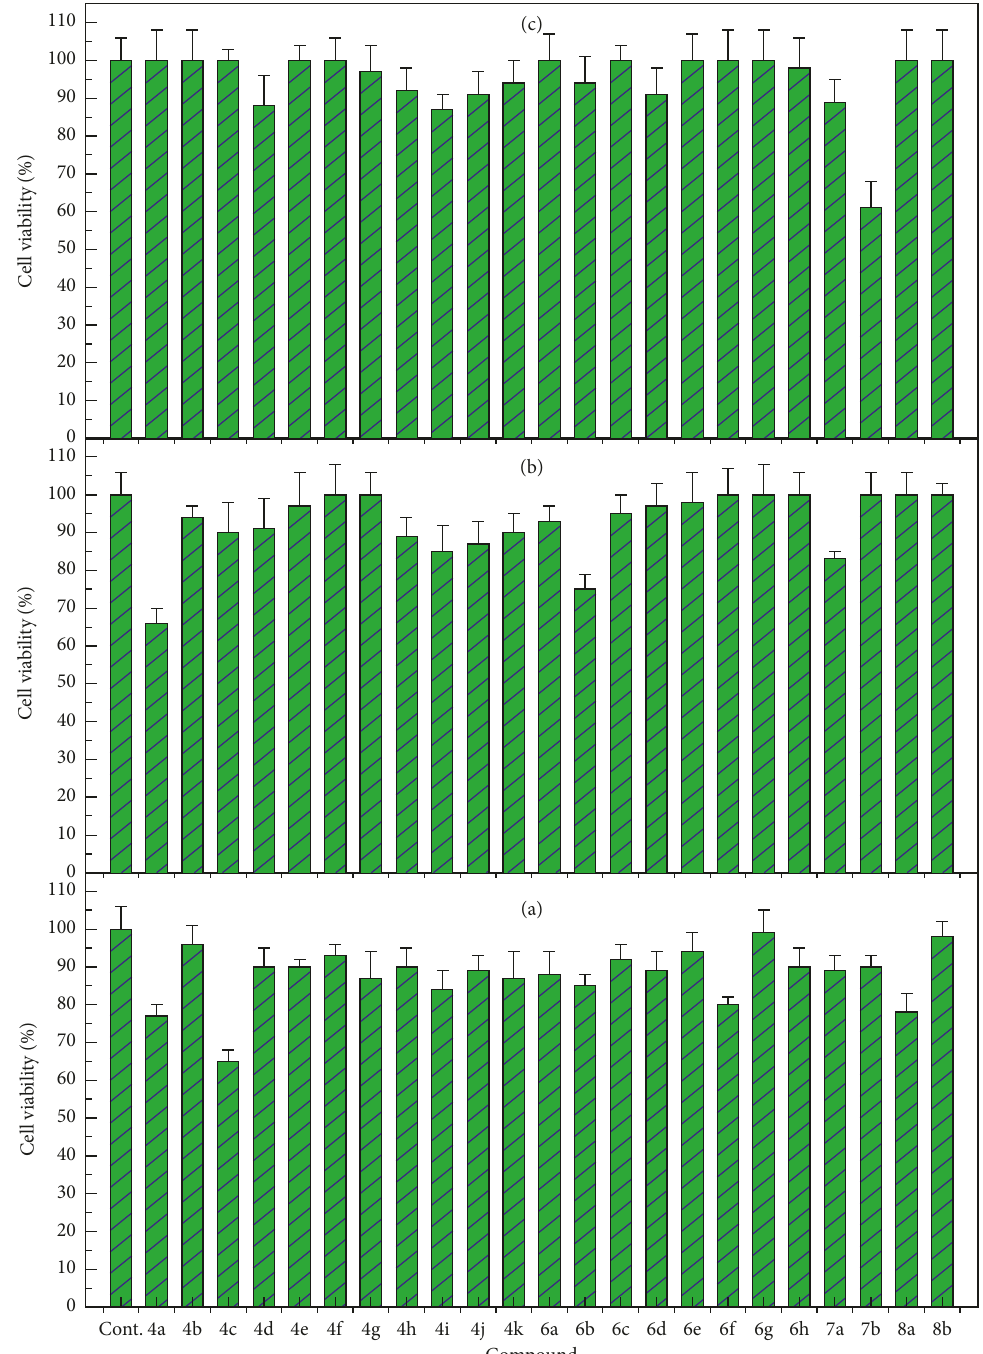
Figure 1: Effect of different compounds on the viability of MCF-7, A549 and HT-29 cell line. Data are represented as mean ± SD. (a) MCF-7; (b) A549; (c)